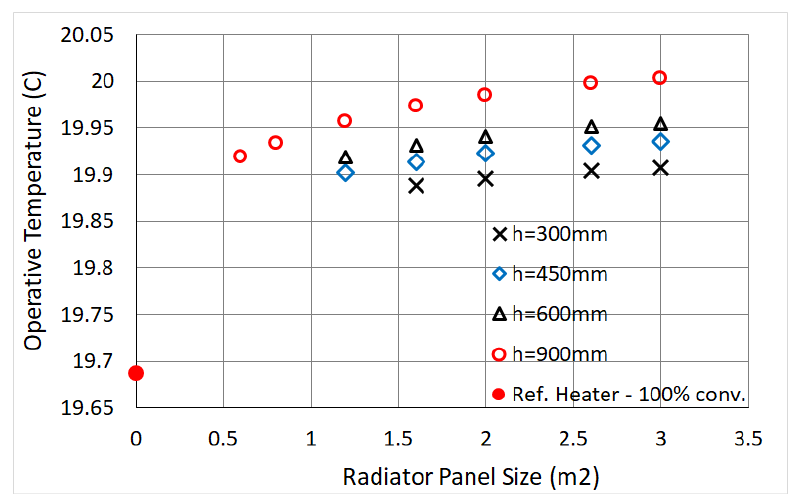
Figure 7. IDA ICE operative temperatures for a 10-type radiator and convector in function of the panel area.